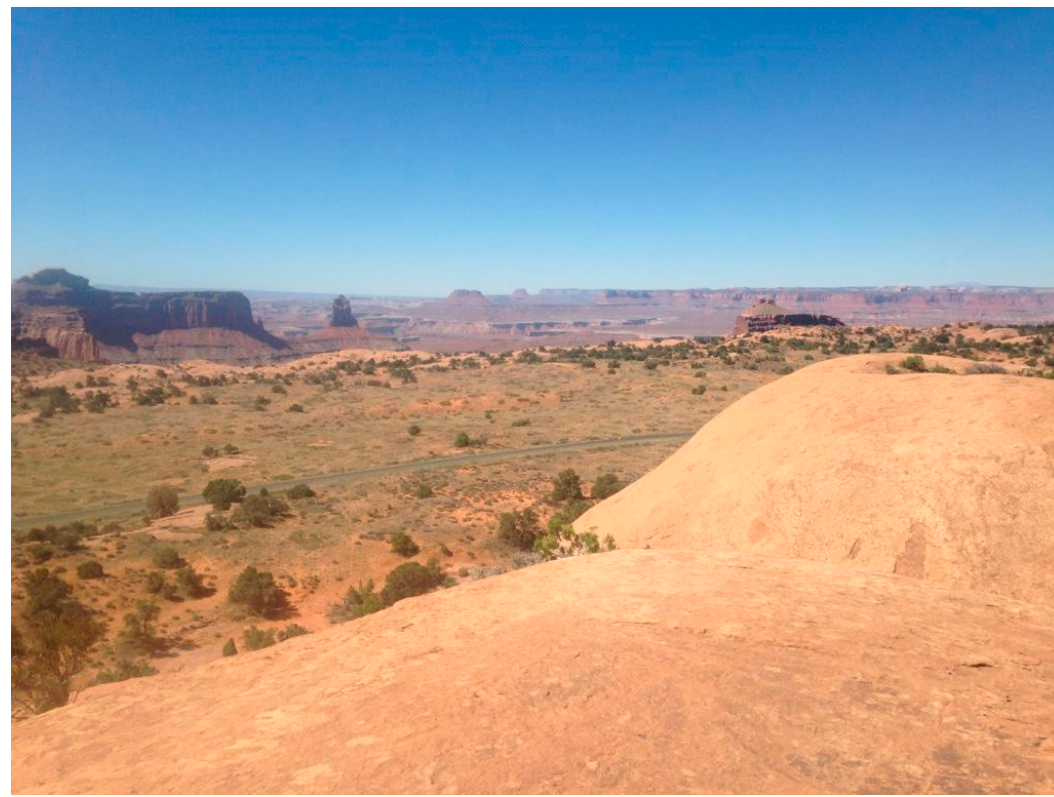
Figure 4. Whale Rock, Canyonlands National Park. Photograph by G.L. Buckley, June 2018.